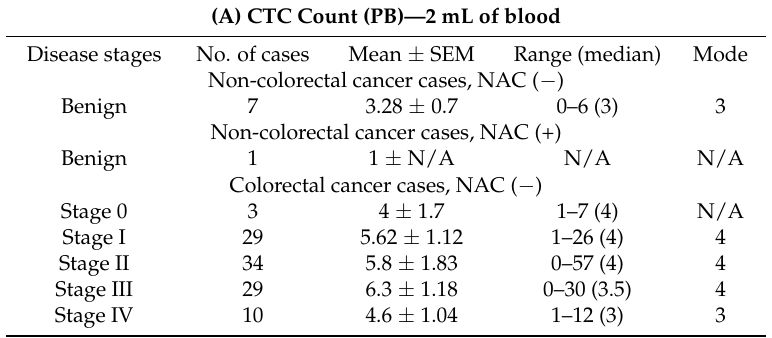
Table 2. Number of circulating tumor cells (CTCs) detected in the colorectal cancer